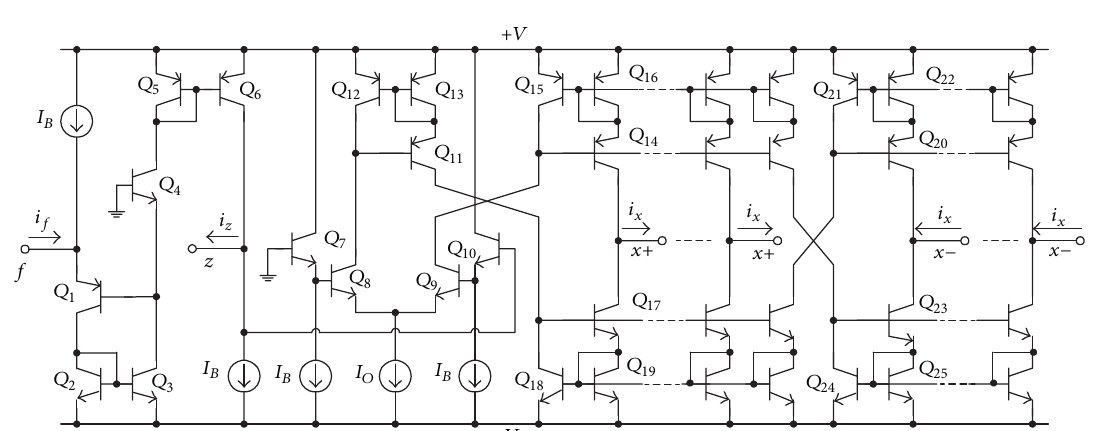
Figure 1: The CFTA.